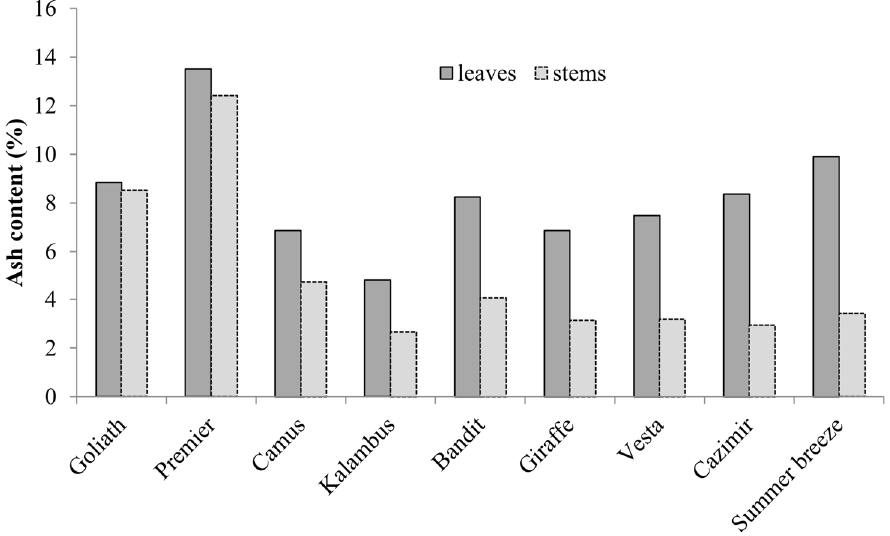
Figure 4. Varietal differences in leek leaf and stem ash content.